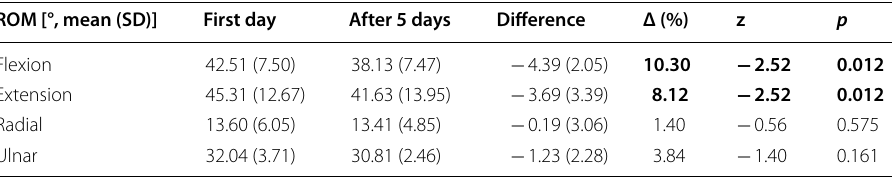
Items in bold: significant t-value ROM: range of motion; SD: standard deviation; Δ: delta Table 7 Changes in the AG before and after 5 days of wearing